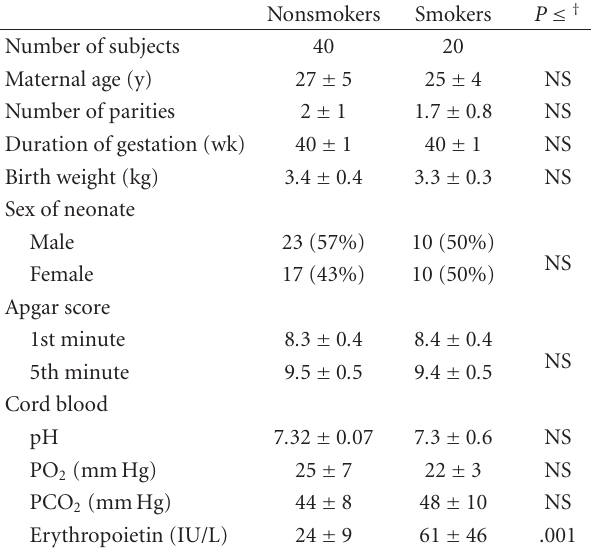
Table 1: Relation between maternal smoking and neonatal characteristics.